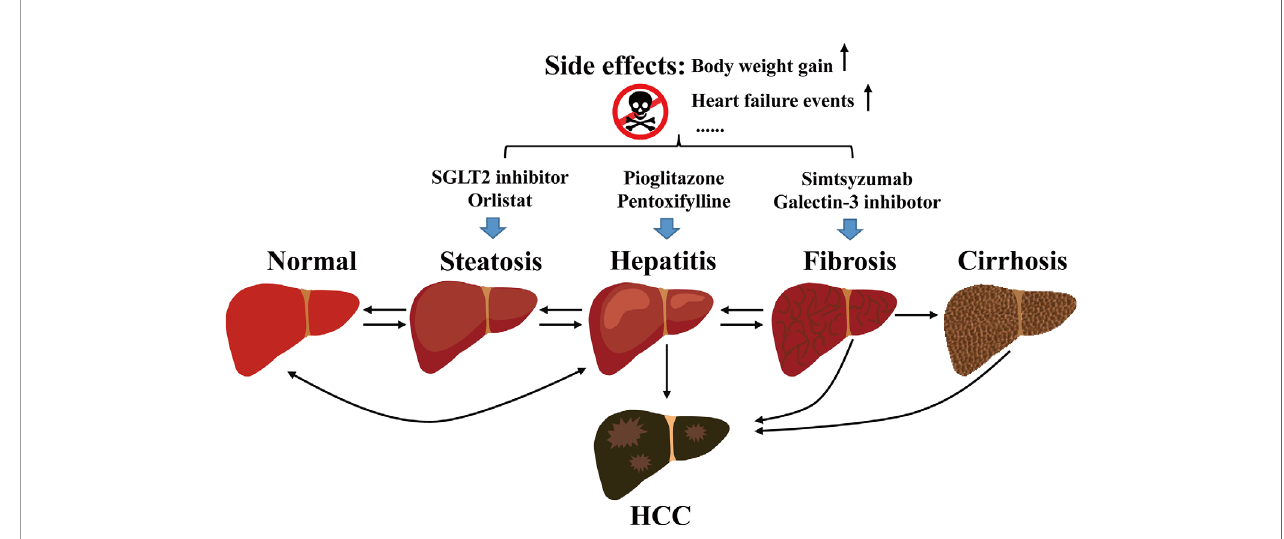
FIGURE 1 | Development of NAFLD and the current